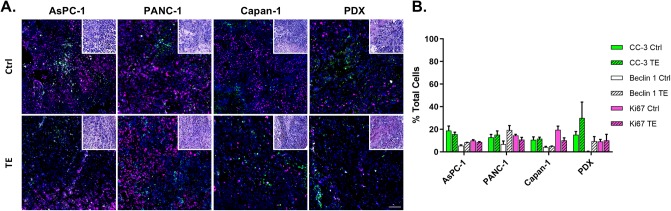
Tumor explant (TE) viability.The IF viability panel (Ki67, CC-3 and Beclin 1) was used to stain four 10 μm tissue sections per time point following tumor resection. A. Representative IF images of tumor tissue sections immediately after resection (Ctrl, top row) or following 72 hours in explant culture (TE, bottom row) are shown false colored as follows: DAPI (nuclear marker, blue), Cleaved Caspase-3 (CC-3, cytosolic staining marking apoptosis, green), Beclin 1 (cytosolic staining marking autophagy, white), Ki67 (nuclear stain marking proliferation, pink). Corresponding H&E images of the preserved tissue morphology are also shown (inset, upper right). Scale bar = 100μm. B. Tissue viability was quantified by assessing positive antibody staining and used to calculate the percentage of stained cells at each time point per condition. N = 3 athymic nude mice (two tumors/mouse) were used per CDX model to provide sufficient starting material for control and treated TE tissue samples.